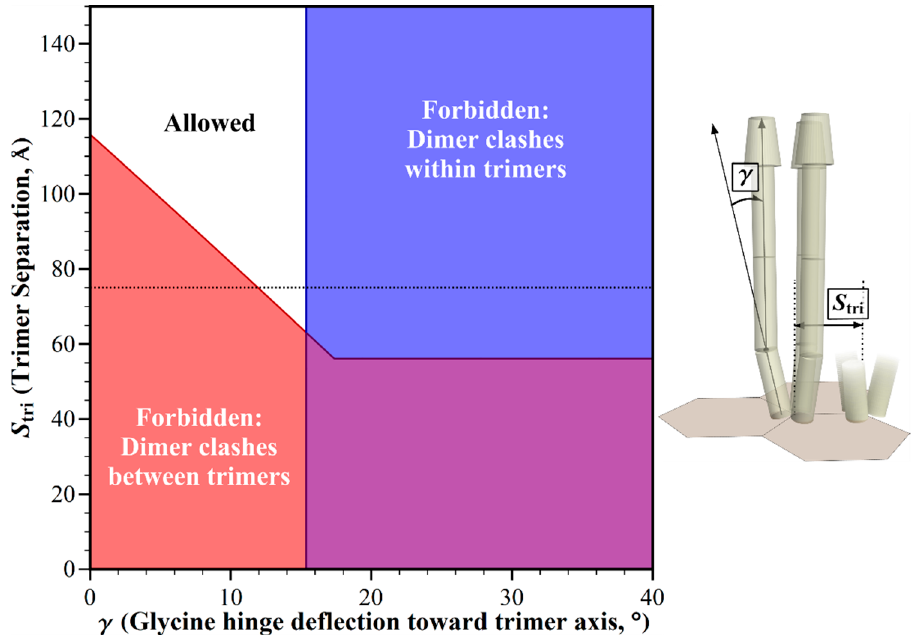
Figure 5. Geometric restrictions in core signaling complexes and their arrays as a function of trimer separation, S tri and glycine hinge deflection, γ . The plot shows the structural consequences of the combinations of trimer separation and glycine hinge deflection. For any allowed combinations (white area), the receptors fit into the available space. For those forbidden combinations, they do not, because of structural clashes between dimers in neighboring trimers (red areas), or in the same trimer (blue areas). The 75 Å trimer separation in E. coli chemoreceptor arrays [5] is marked with a dotted line.